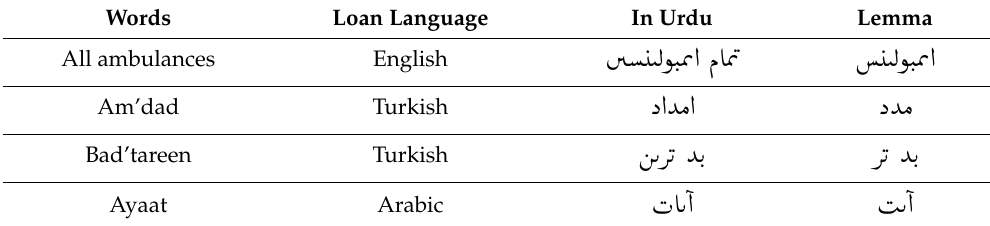
Table 7. Lemmas of loan words in the Urdu language.